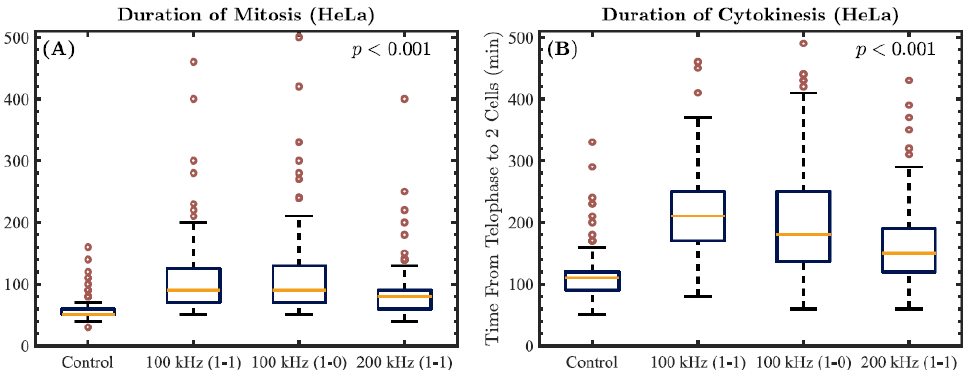
Figure 6. The durations of mitosis and cytokinesis obtained from three independent experiments with HeLa cells in a variety of scenarios: control, 100 kHz (1-1 duty cycle), 100 kHz (1-0), and 200 kHz (1-1). The p -value overlaid on each plot corresponds to the results obtained from two-sample t -tests comparing the displayed data for HeLa cells in each TTFields-exposed group to those of the control cells. ( A ) Boxplots representing the duration of mitosis, calculated from nuclear envelope breakdown (NEBD) to anaphase. ( B ) Boxplots representing the duration of cytokinesis, calculated from telophase to the formation of two separated daughter cells. Data are displayed as the median duration flanked by upper and lower quartiles, with outliers shown as red circles.